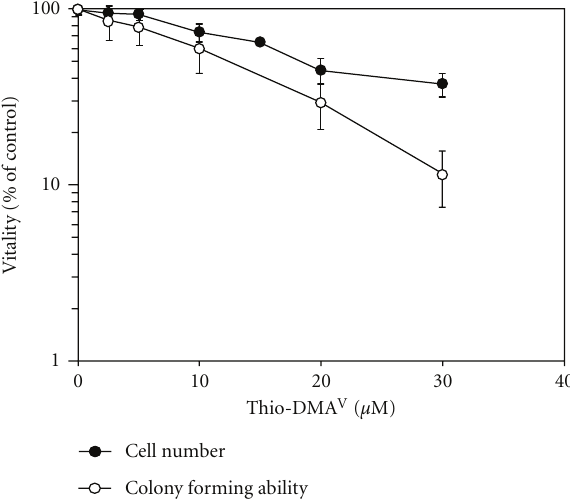
Figure 3: Cytotoxicity of thio-DMA V in A549 cells after 24 h incubation. Cytotoxicity was determined by a decrease in cell number (closed symbols) and e ff ects on colony forming ability (open symbols). The data represent mean values of at least six determinations ± SD.